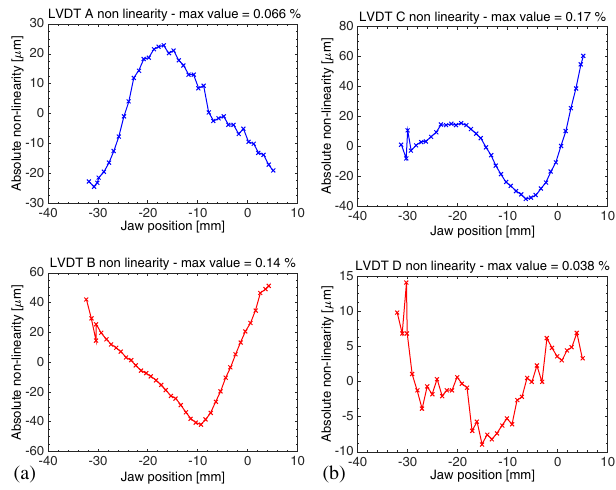
FIG. 7. Differences measured in the LVDT position (non- linearities) with respect to the collimator jaw motor positions over the full range of movement. (a) Nonlinearity A and B and (b) Nonlinearity C and